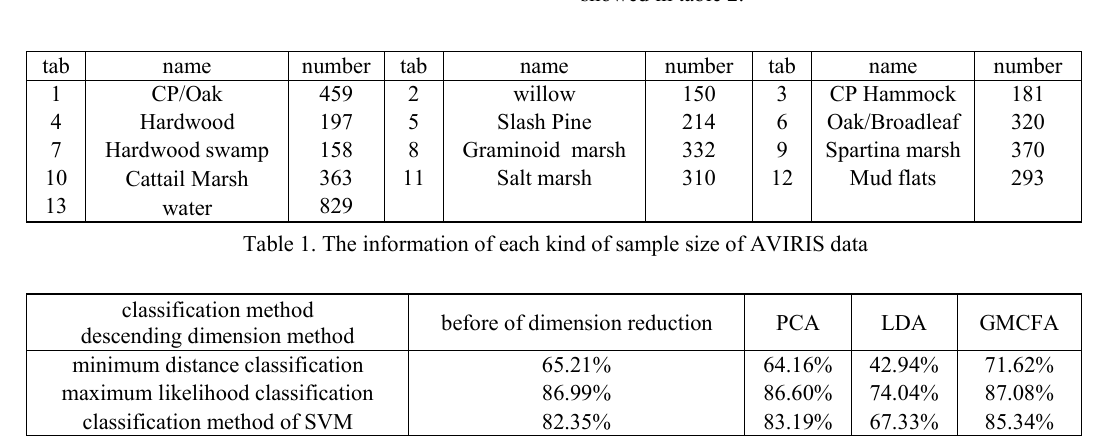
Table 2. The comparison of classification overall accuracy under different dimension reduction algorithm of AVIRIS data Can be seen from table 2, the accuracy decreased after use of PCA and LDA algorithm dimension reduction, fall is larger for the LDA algorithm; After use of the proposed algorithm, the classification accuracy of the method are